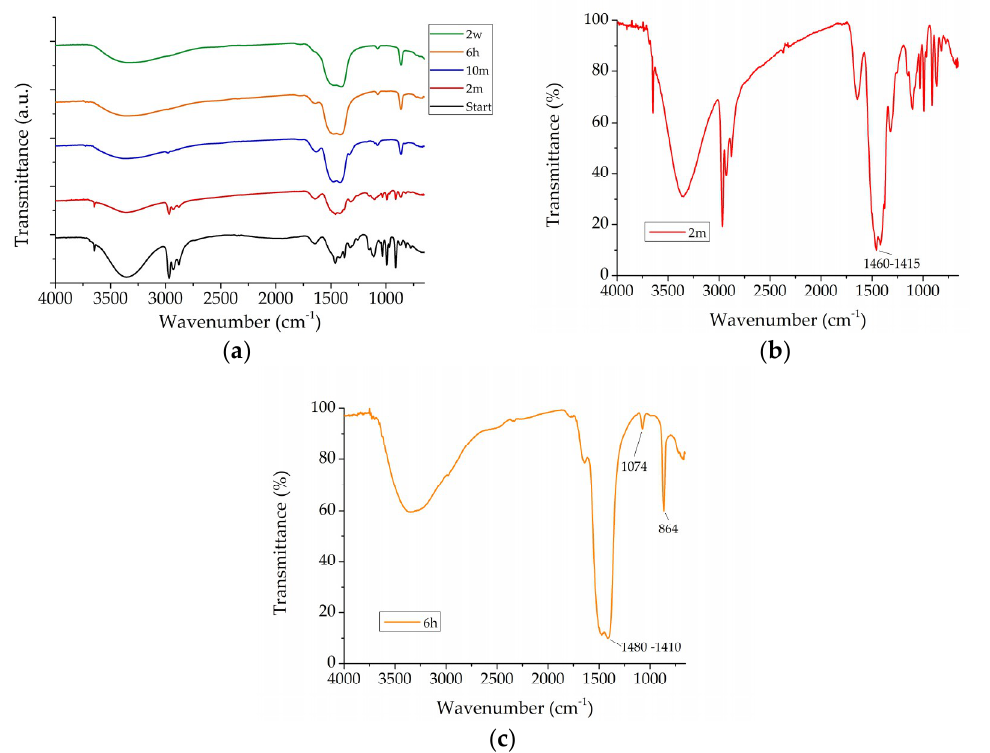
Figure 1. Fourier transform infrared spectroscopy (μFT-IR) spectra showing the kinetic process of 2BU: ( a ) all spectra recorded at different times, ( b ) spectrum acquired after two minutes and ( c ) spectrum acquired after six hours. Time intervals: Start, beginning of the reaction (black); 6m, six minutes (red); 10m, ten minutes (blue); 6h, six hours (orange); 2w, two weeks (green).